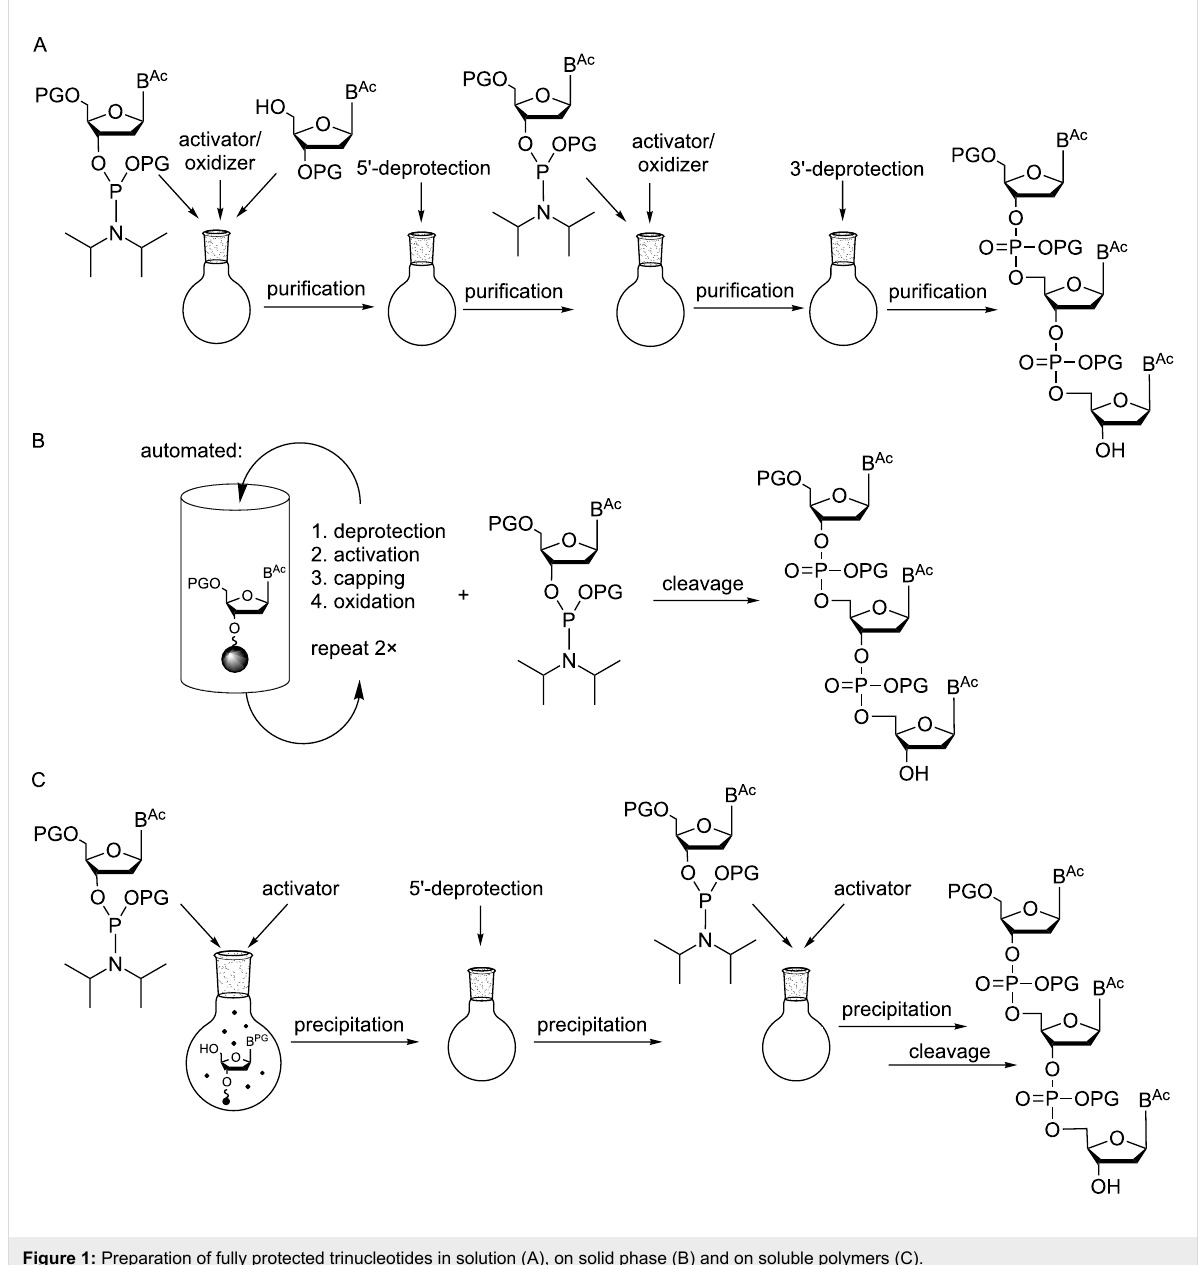
Figure 1: Preparation of fully protected trinucleotides in solution (A), on solid phase (B) and on soluble polymers (C).